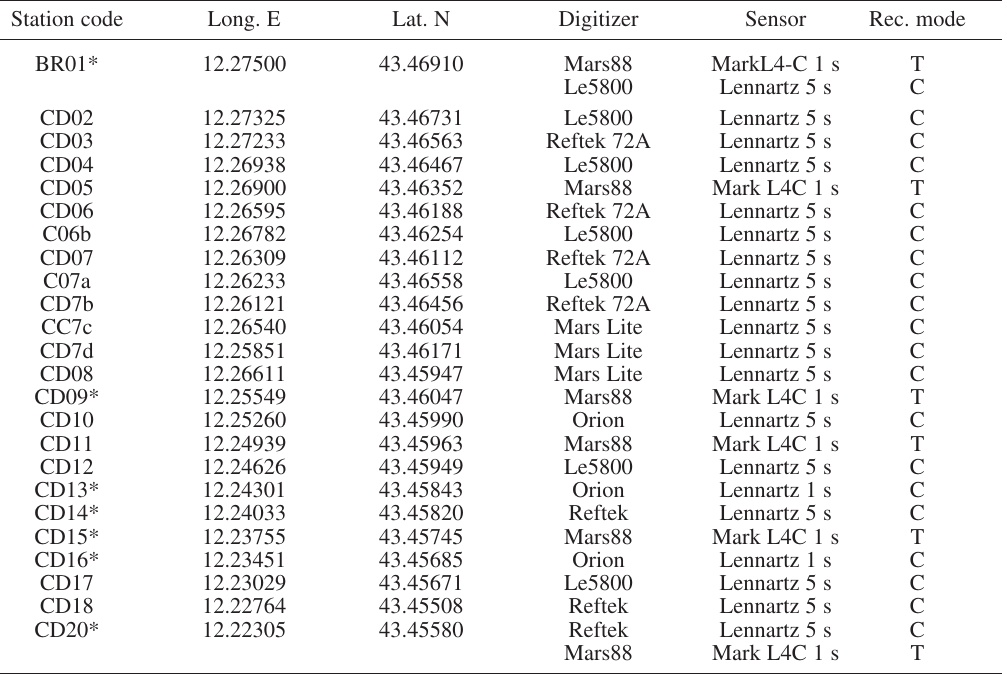
Table I. The symbol (*) in the station code column indicates the sites in common with the Regione Umbria re- search project (April 2000 to December 2000). In Rec. mode column, C is for continuous recordings and T for trig- ger mode. Station code Long. E Lat. N Digitizer Sensor Rec. mode